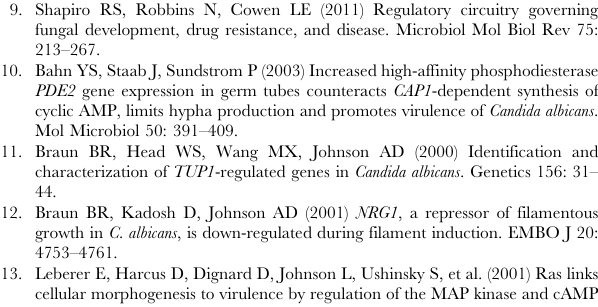
Table S1 Strains used in this study. Table S2 Plasmids used in this study. Table S3 Oligonucleotides used in this